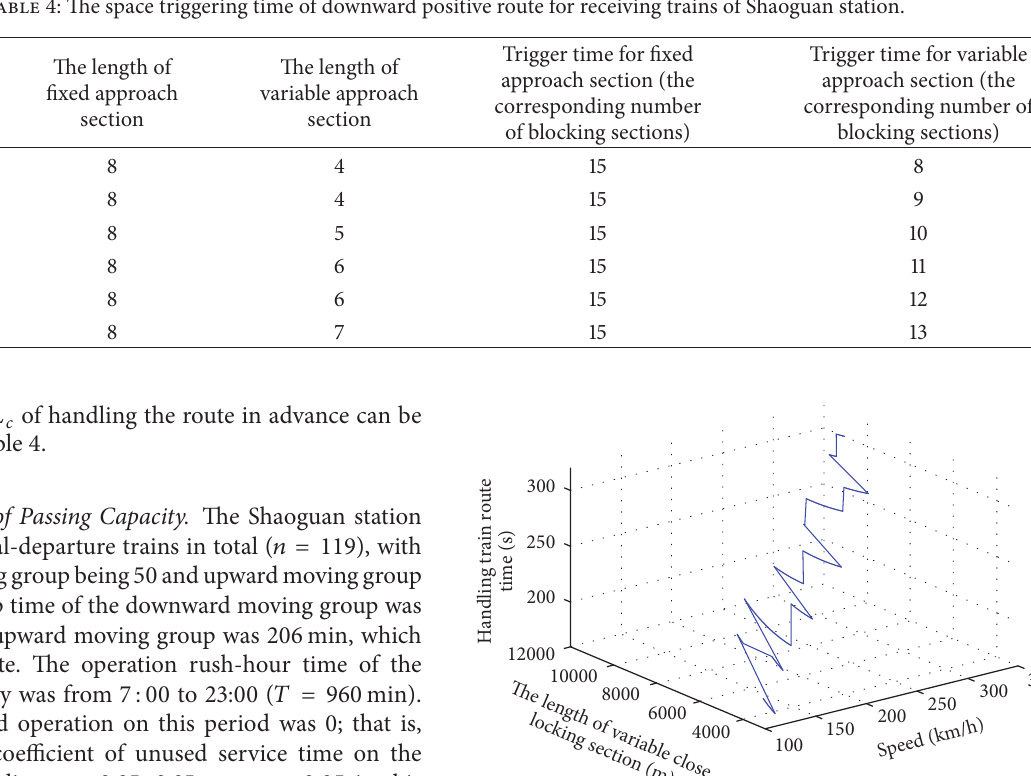
Table 4: The space triggering time of downward positive route for receiving trains of Shaoguan station.